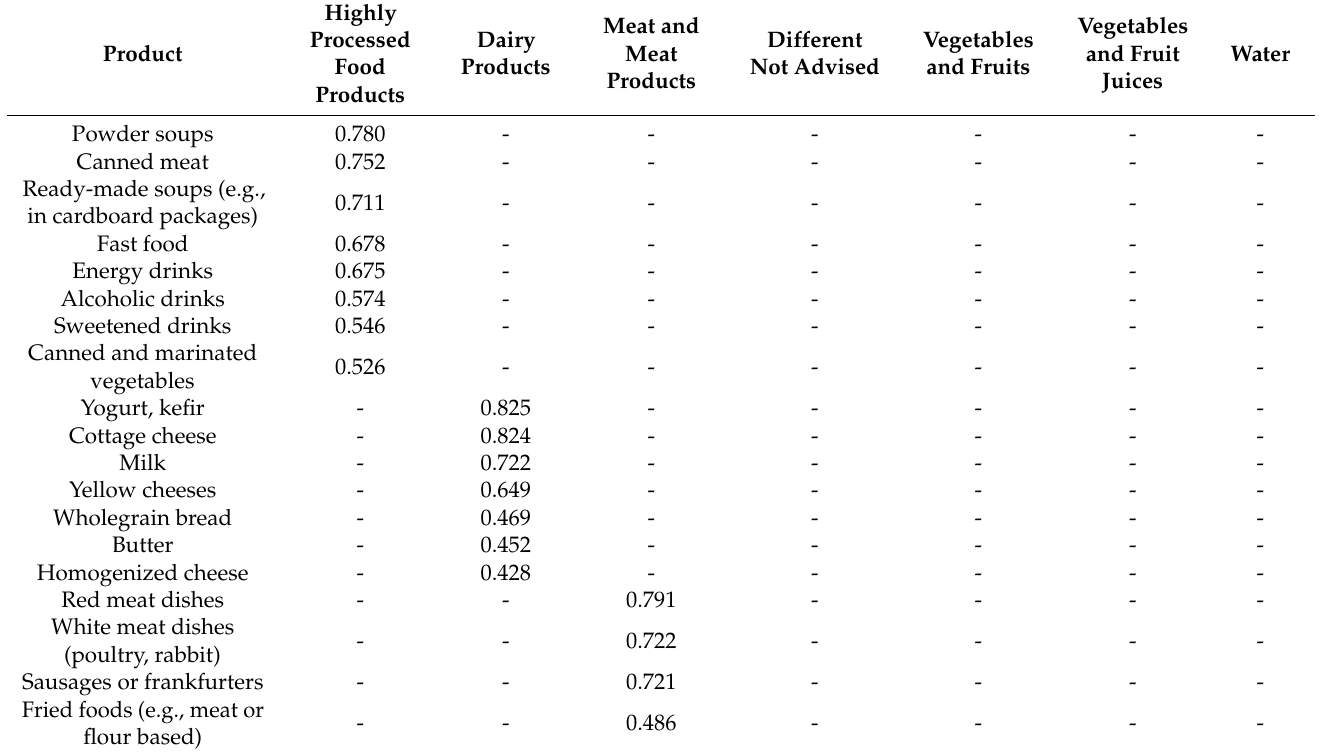
Table 1. Factor-loading matrix identified by factor